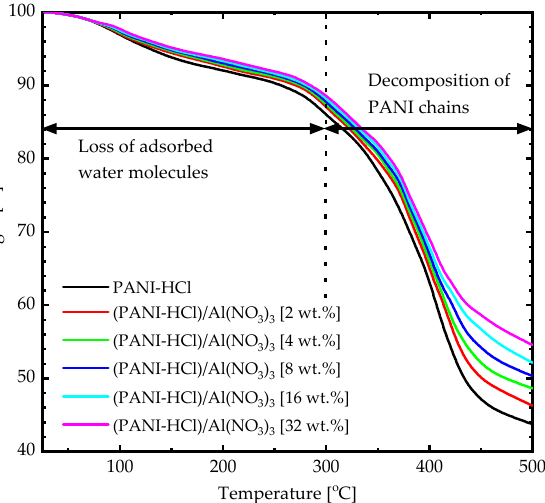
Figure 5. TGA curves of (PANI-HCl)/Al(NO 3 ) 3 complex composite films with various Al(NO 3 ) 3 concentrations.